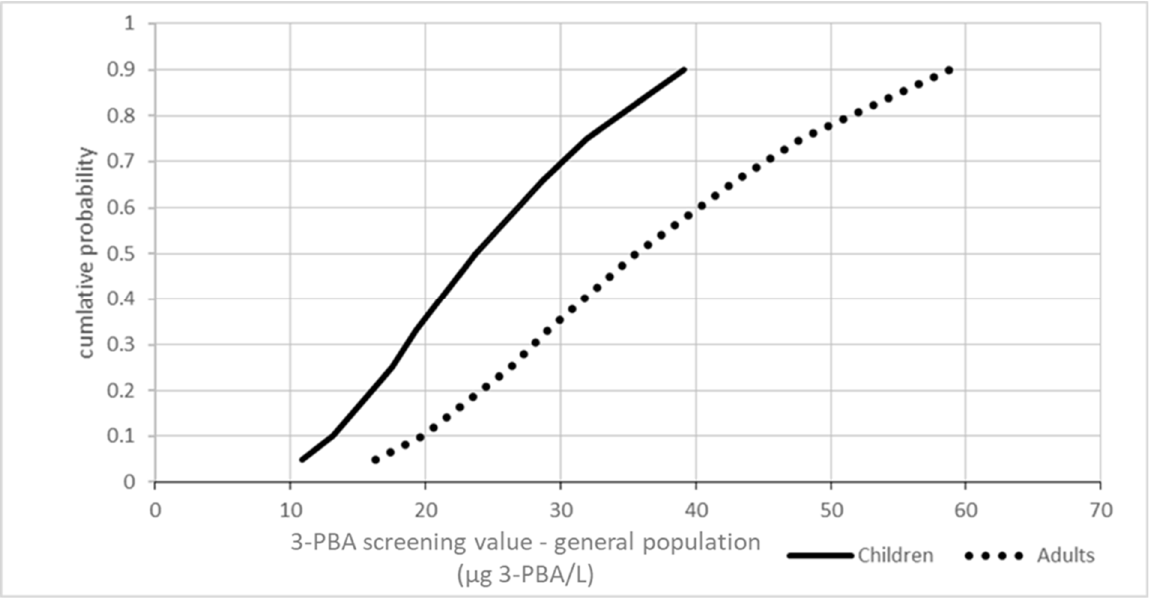
Figure 2. Cumulative probability distribution of the 3-PBA HBM screening value for the general population, accounting for the variability in human toxicokinetics.